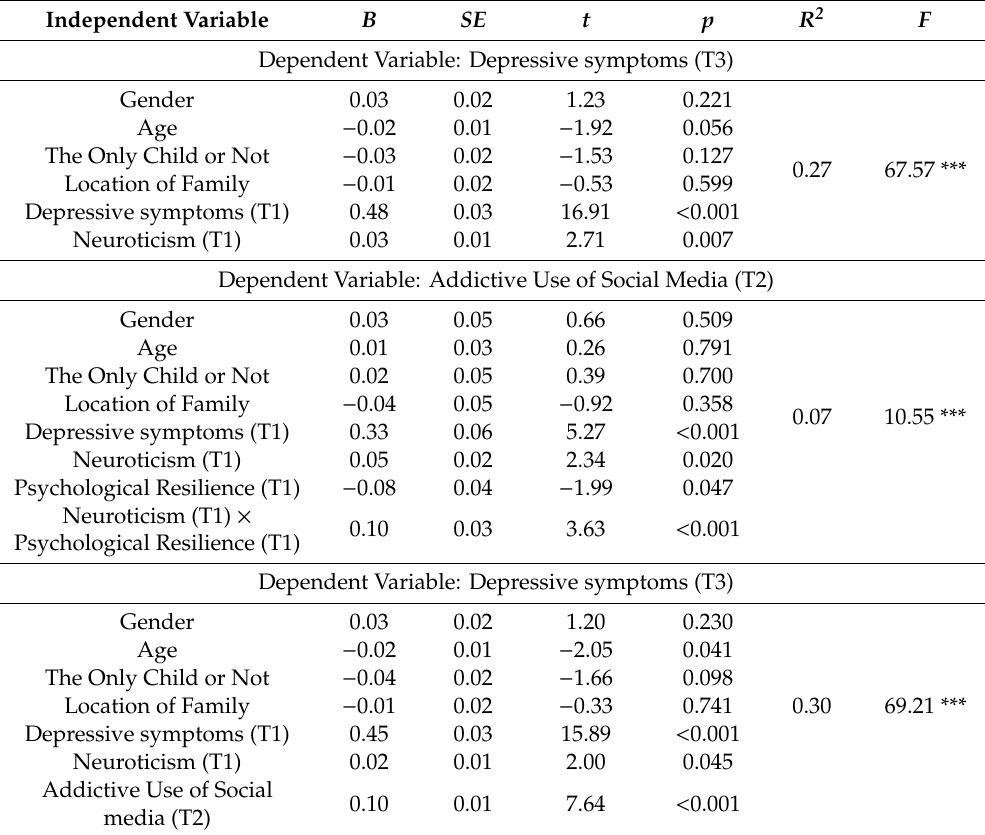
Table 2. Multiple regression results of the moderated mediation